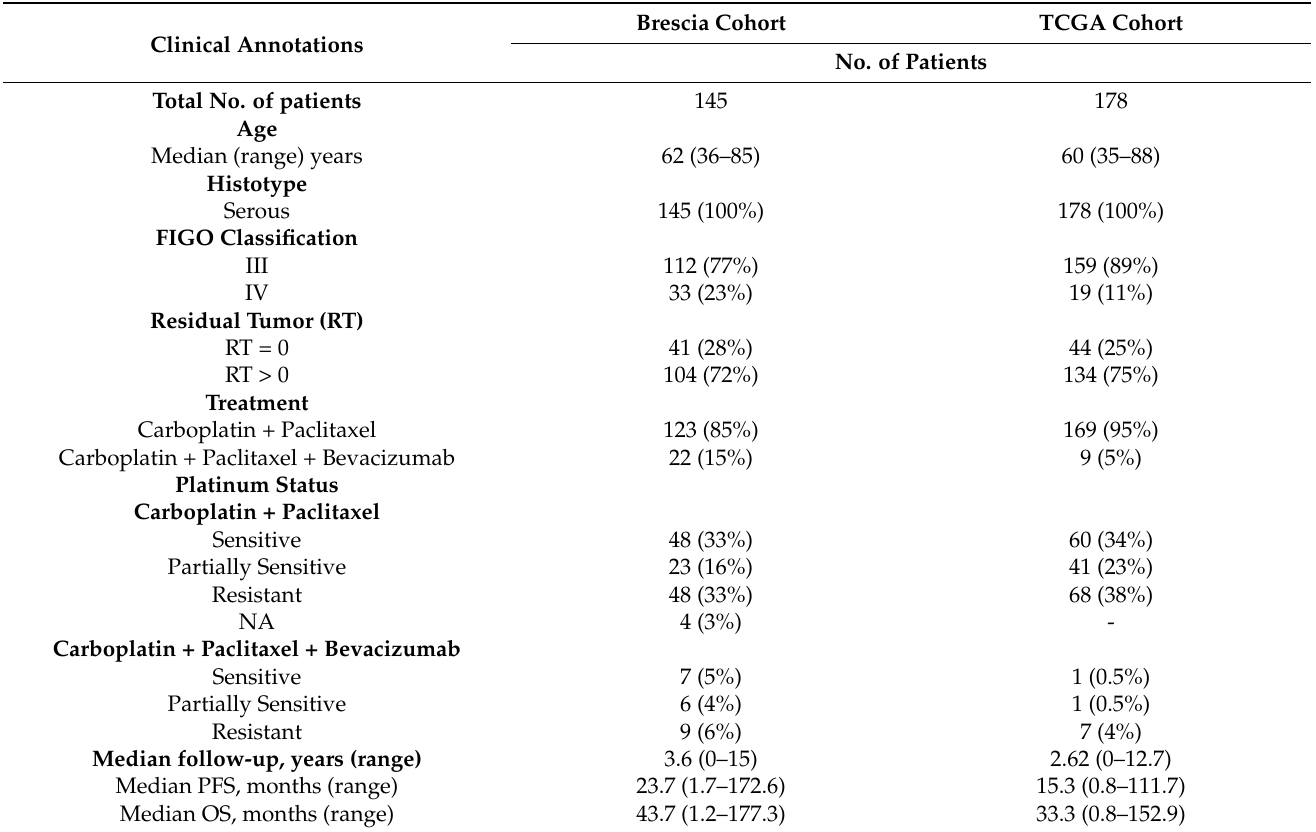
Table 1. Clinicopathological characteristics of HGSOC patients in the Brescia and TCGA